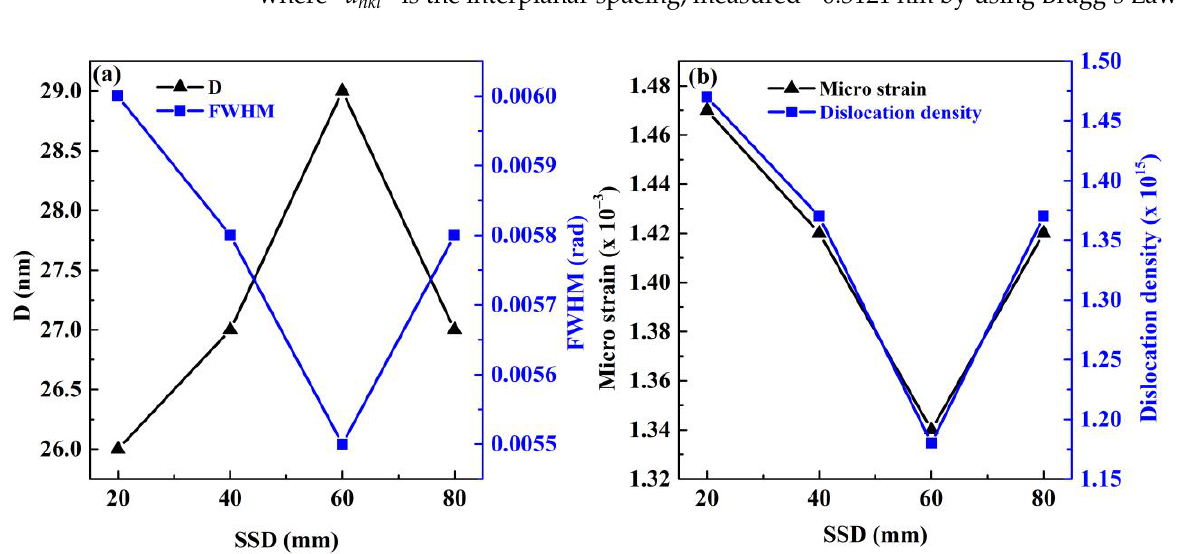
Figure 2. ( a ) The FWHM (rad) of the (111) plane and crystallite size (nm) and ( b ) the microstrain (×10 −3 ) and dislocation density (×10 15 m −2 ) of deposited ZnS thin films against SSD.